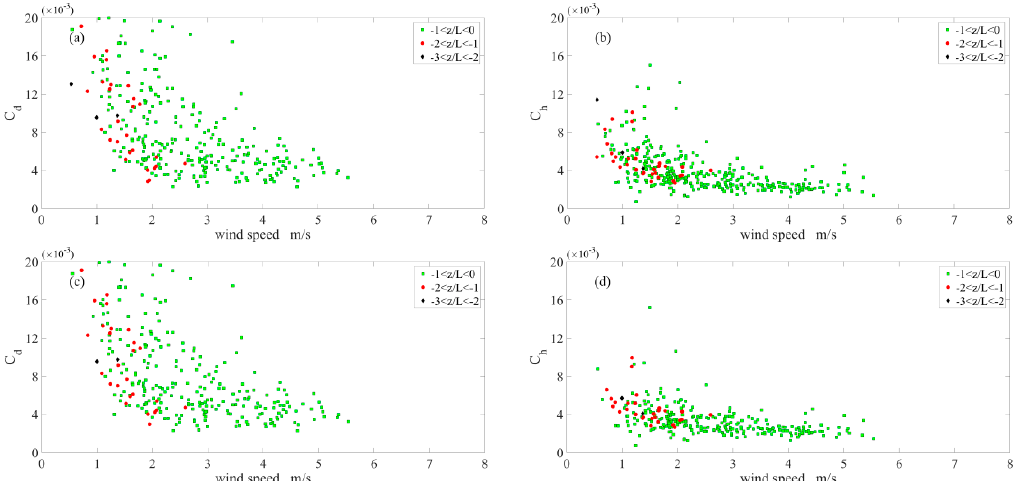
Figure 14. ( a ) Relationship between the bulk transfer coefficient C d and wind speed with wind directions of NNE–SES from 5 January to 31 December 2010. ( b ) Same as ( a ) but for C h . ( c ) Same as ( a ) but according to the revised M–O similarity function. ( d ) Same as ( b ) but according to the revised M–O similarity function.